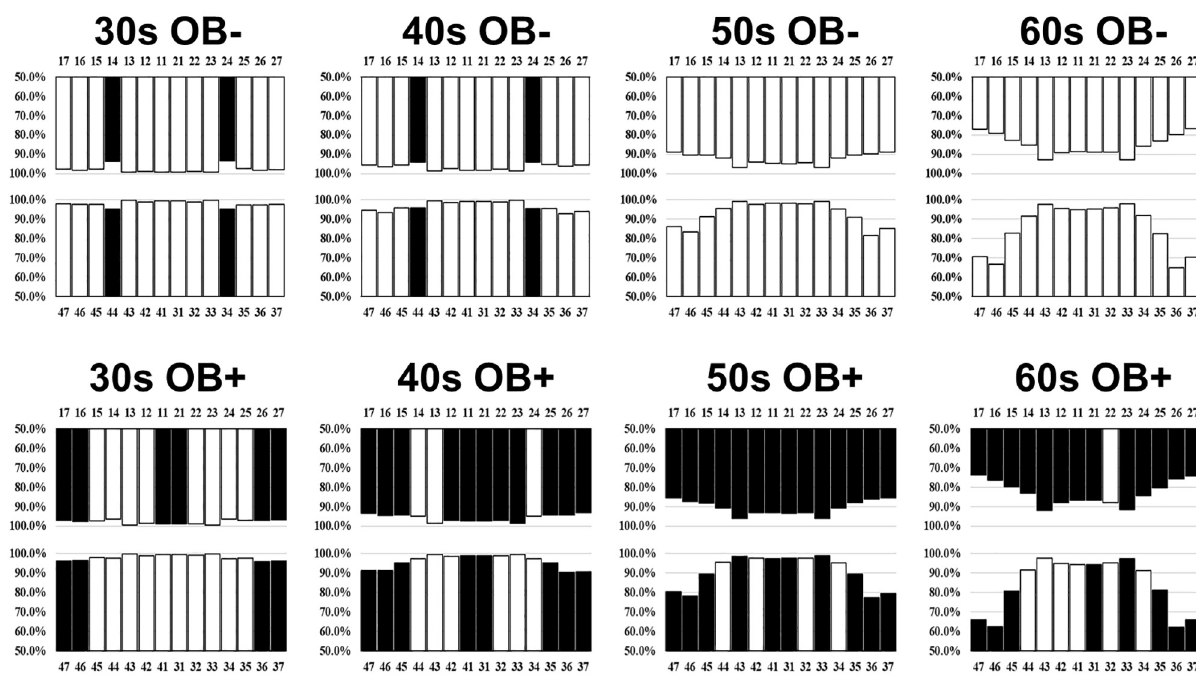
Fig 3. Percentage of subjects with residual teeth at each position in groups with non-obesity (BMI < 25.0 kg/m 2 ) and obesity ( � 25.0 kg/m 2 ) by age groups (30s-60s). The percentage of subjects with residual teeth was calculated as the proportion of subjects that have a residual tooth at the particular position. The percentage of subjects with residual teeth was compared between the groups with obesity and non-obesity in the same age group, and positions with a significantly lower percentage of subjects having residual teeth are shown in black ( p < 0.05). OB+: obesity, OB-: non-obesity.